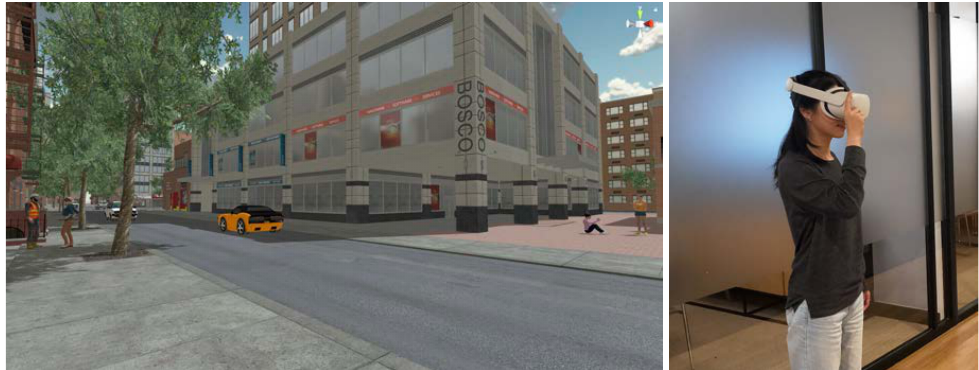
Figure 4. The simulated environment used in the AV study ( left ) and a participant tapping on the headset to send a crossing request ( right